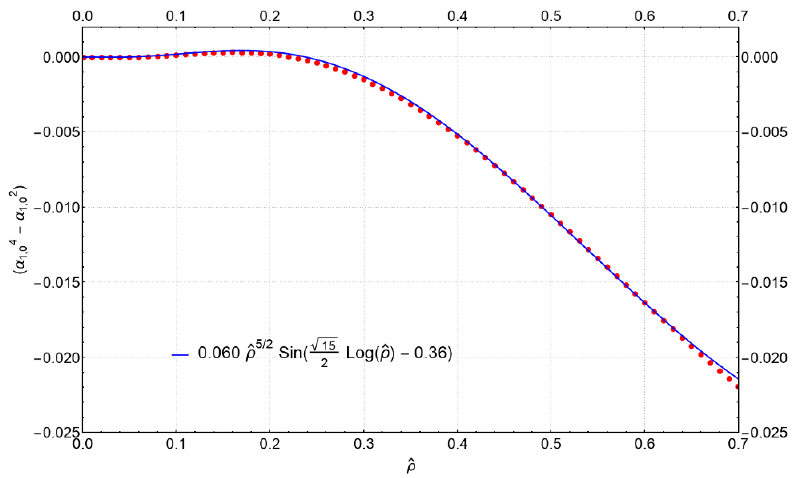
(cid:0) ^ (cid:11) 2 for M = S 2 (cid:2) S 4 when S 2 1 ; 0 1 ; 0